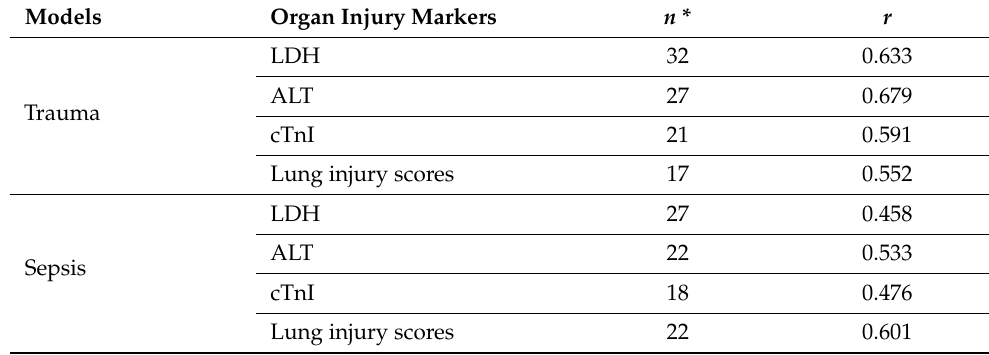
Table 3. Correlation of circulating histones to organ injury markers in mouse